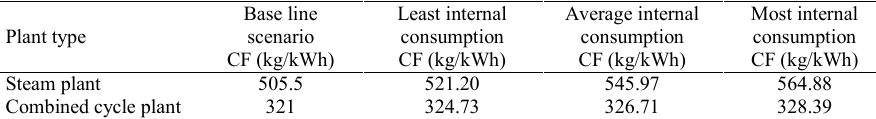
Table 10: The final group of scenarios investigating degradation on carbon footprint